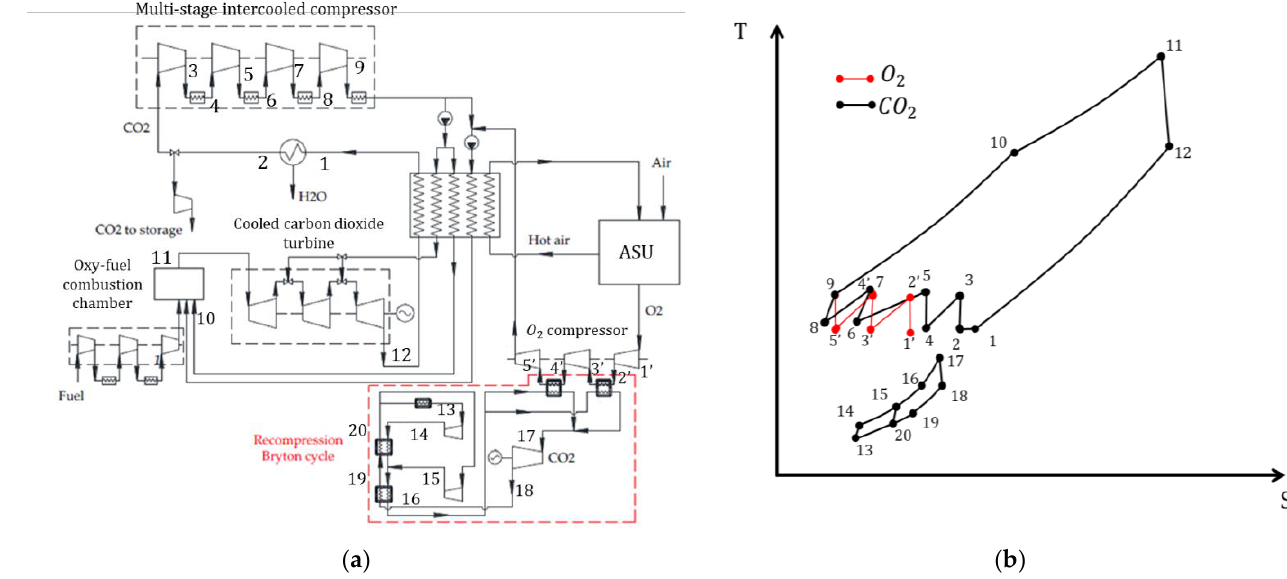
Figure 24. Allam cycle with WHR: ( a ) schematic diagram; ( b ) T – S diagram [40]. ASU — air separation unit.